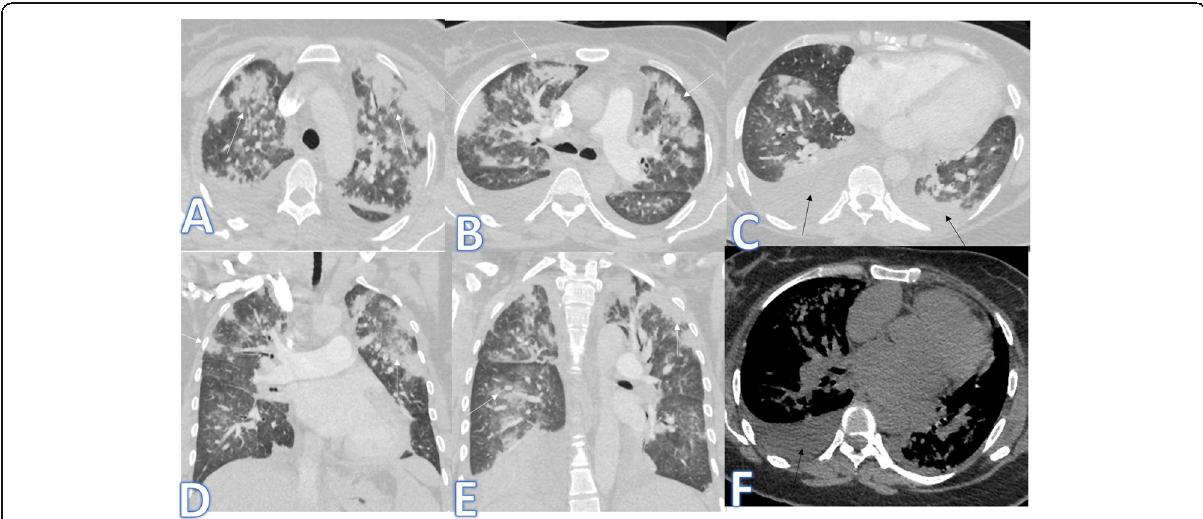
Fig. 17 A 49-year-old female patient presented with fever, cough, and dyspnea. CT showed bilateral confluent consolidative patches with upper lobe predilection (white arrows) and bilateral mild pleural effusions (black arrows); the diagnosis was drug rash with eosinophilia and systemic symptoms